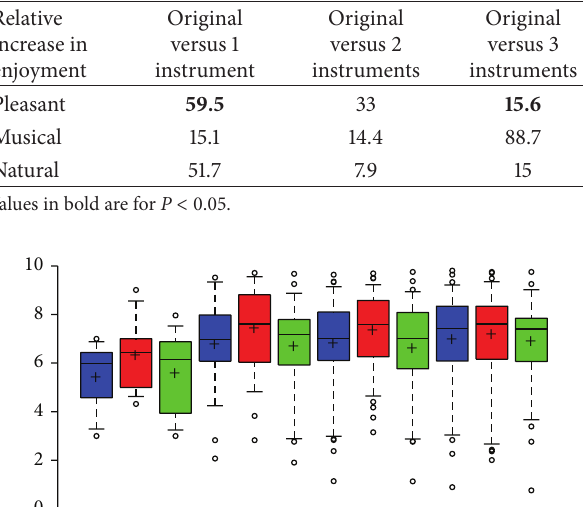
Table 1: Relative reduction of enjoyment of the original music sample compared to modified versions containing 1–3 instruments among NH listeners without CI simulation.